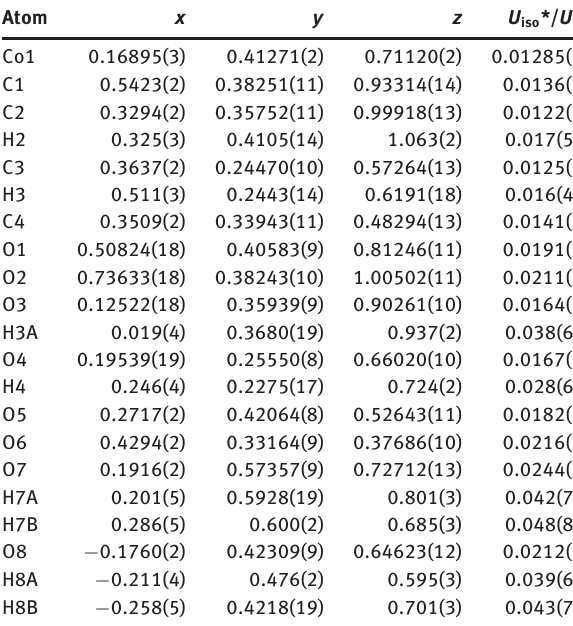
Table 2: Fractional atomic coordinates and isotropic or equivalent isotropic displacement parameters (Å 2